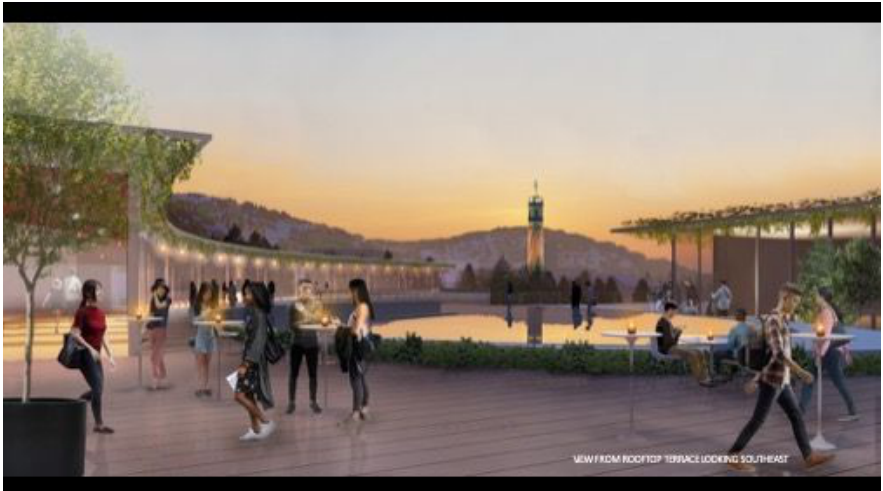
Figure 4. View of event space on the roof, looking towards the UC Berkeley